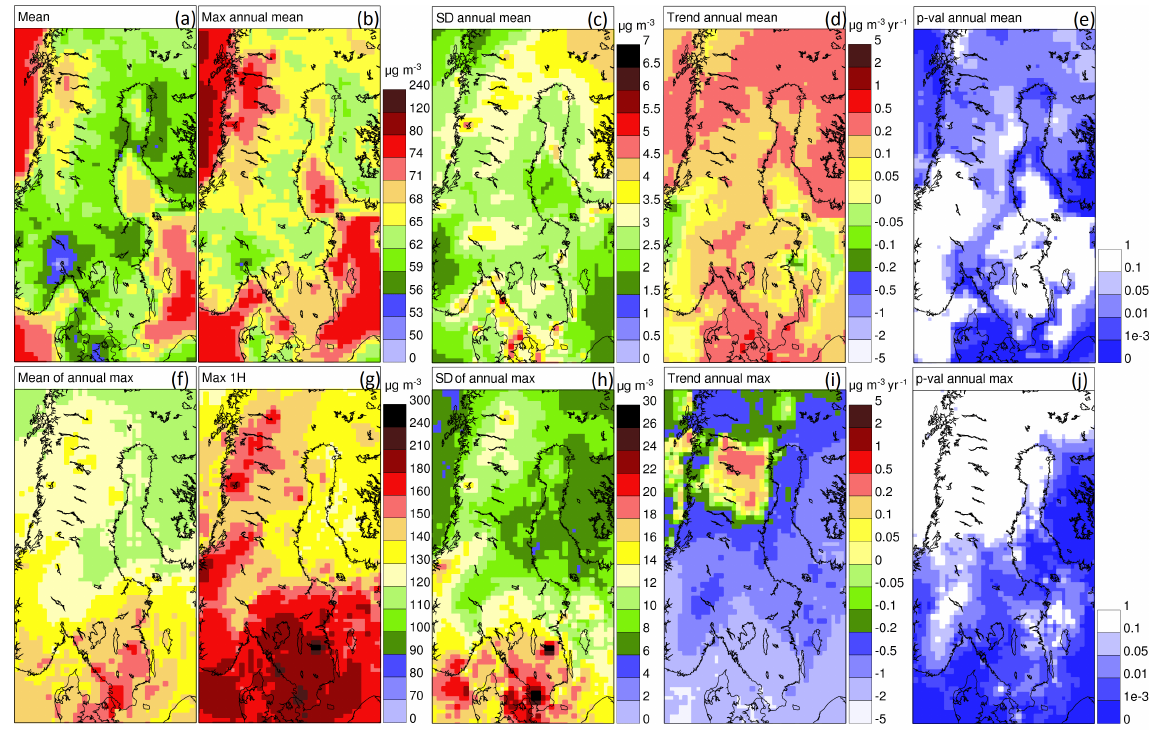
Figure 7. Statistical properties of the annual mean (top row; a–e ) and annual maximum 1h mean (bottom row; f–j near-surface ozone concentration. In the columns from left to right: 1990–2013 mean (a, f) , 1990–2013 maximum (b, g) , 1990–2013 standard deviation (c, h) , linear trend over the period 1990–2013 (d, i) and significance in the linear trend over the period (e, j) . Results from the LONGTERM